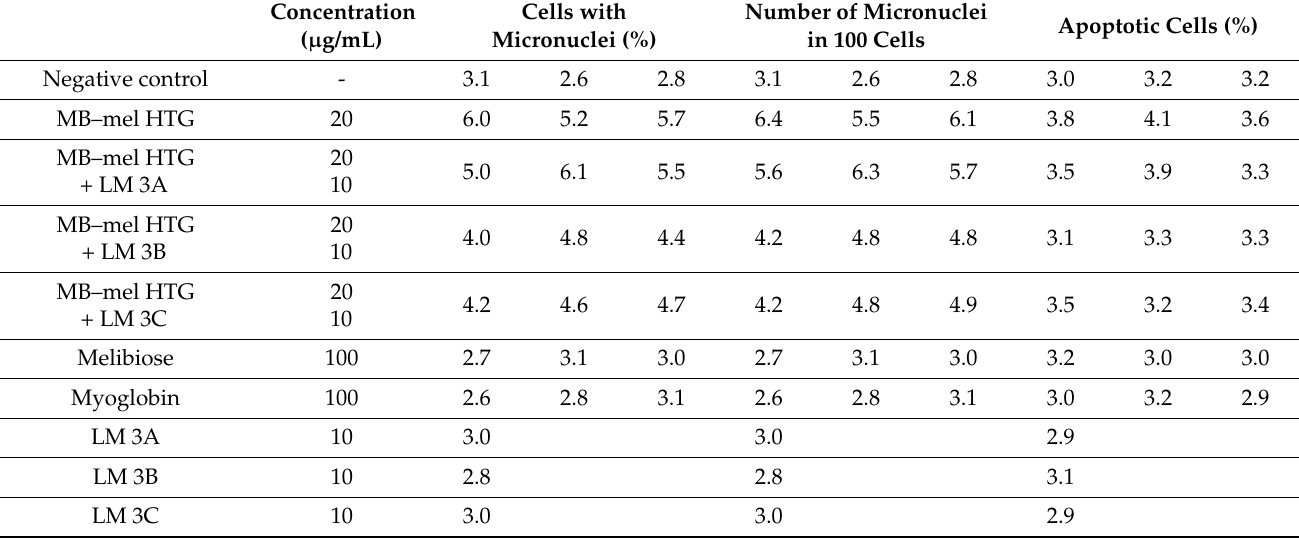
Table 8. The effect of LMW–MAGE on genotoxic activity of HTG glycation products in BEAS-2B cells. Concentration